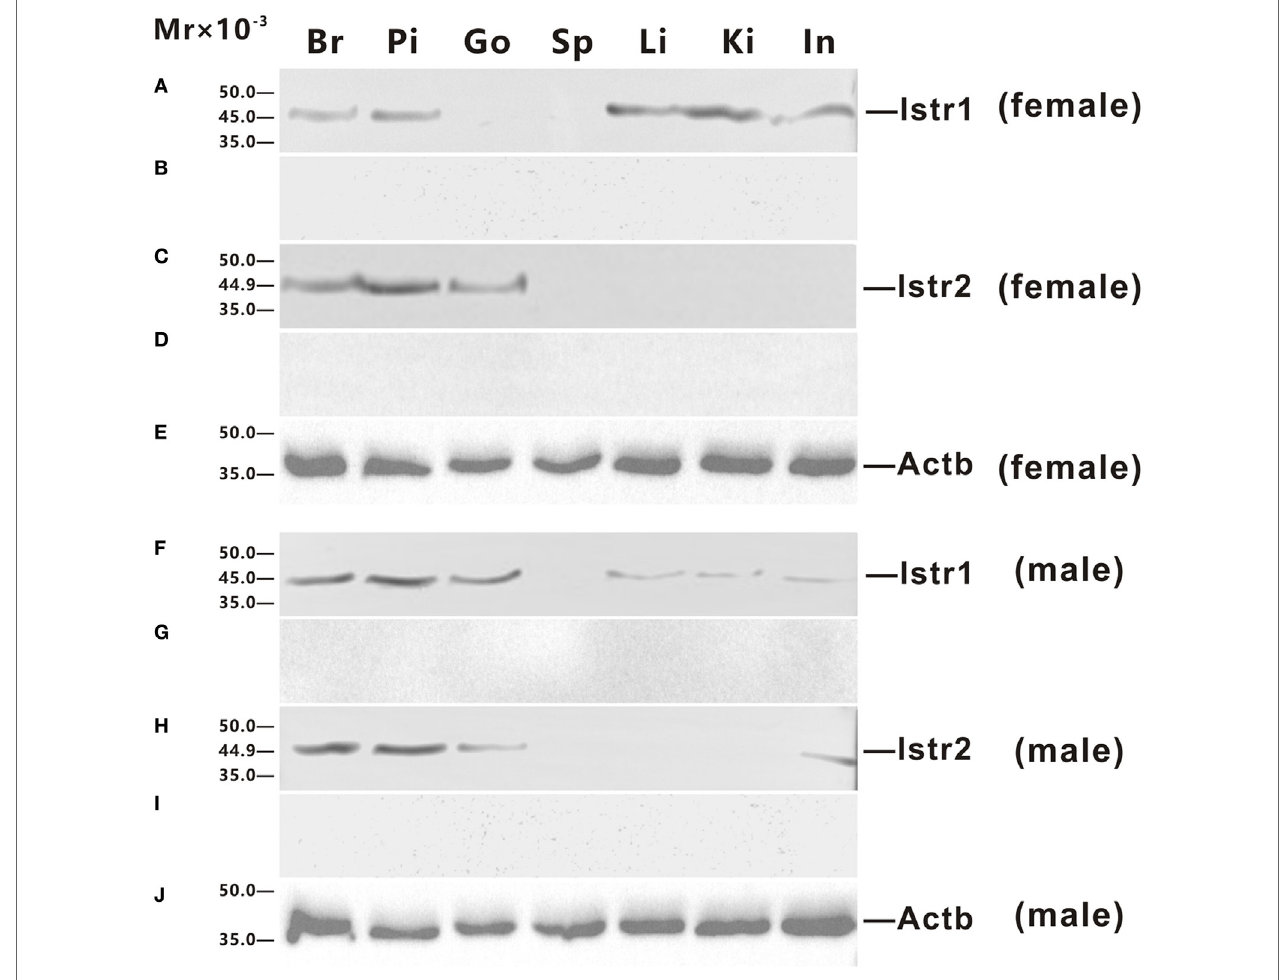
FigUre 4 | Western blot analysis of immunoreactive isotocin (Ist) receptor 1 (Istr1) and Istr2 in tissues of female (a–e) and male (F–J) ricefield eels. The tissue homogenates (500 µg) from the brain (Br), pituitary (Pi), gonad (Go), spleen (Sp), liver (Li), kindey (Ki), and intestine (In) were separated on 12% SDS-PAGE gels, transferred to polyvinylidenefluoride membranes, and then immunoreacted with the rabbit anti-Istr1 antiserum [1:1,000; (a,F) ], or rabbit anti-Istr1 antiserum pre-absorbed by excessive recombinant full-length Istr1 (B,g) , or the rabbit anti- Istr2 antiserum [1:1,000; (c,h) ], or rabbit anti-Istr2 antiserum pre-absorbed by excessive recombinant full-length Istr2 (D,i) , or mouse anti-Actb monoclonal antibody [1:2,000; catalog number: 60008-1-Ig; ProteinTech Group, Inc.; (e,J) ]. The secondary antibody was 1:5,000 diluted horseradish peroxidase (HRP)-conjugated goat anti-mouse immunoglobulin G (IgG) (H + L) (catalog number